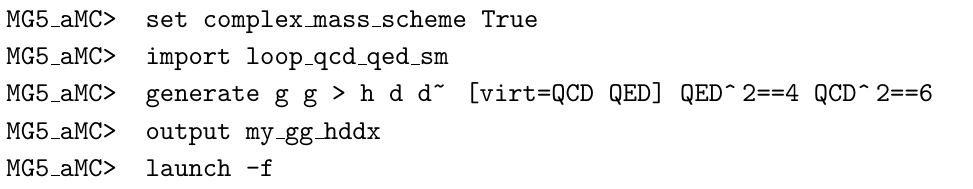
Hd (cid:22) d presented in table !